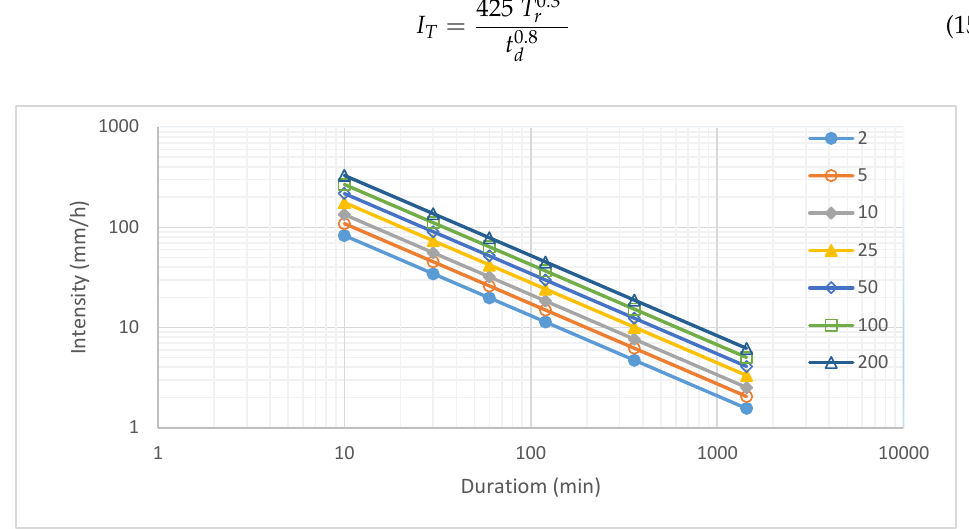
Figure 9. IDF curves of the Wadi Yalamlam area.